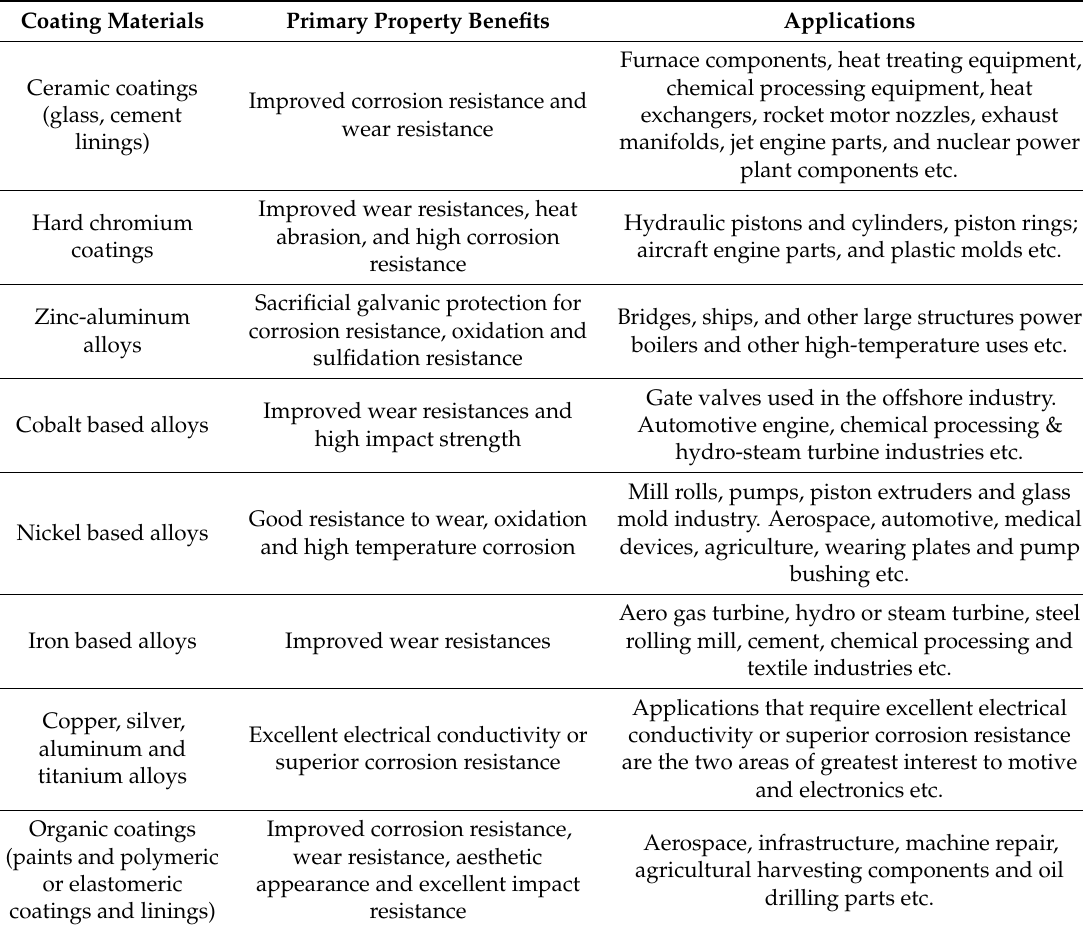
Table 1. Applications and properties of cold spray coating materials